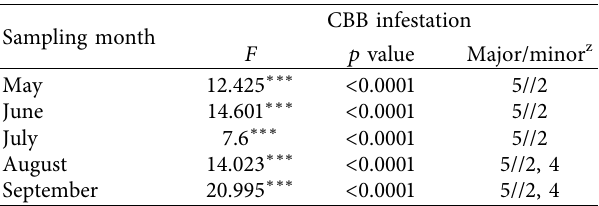
Asterisks indicate a signifcant efect of interaction on the CBB infestation. Generalized linear mixed models: ∗∗∗ � p < 0.001, ∗∗ � p < 0.01, ∗ � p < 0.05, and ns � p > 0.1. z Treatment with major and minor